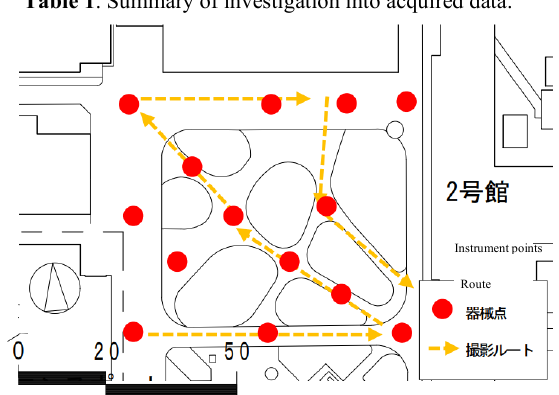
Figure 1 . Details of the subject